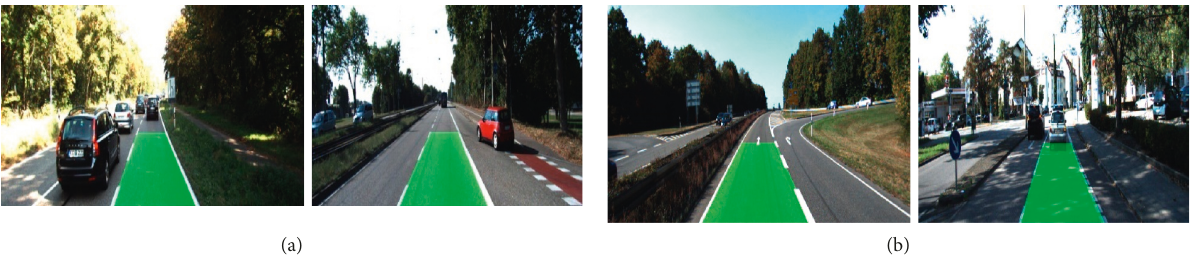
Figure 19: Results of lane detection for different conditions: (a) shade and (b) good lighting in the KITTI dataset.